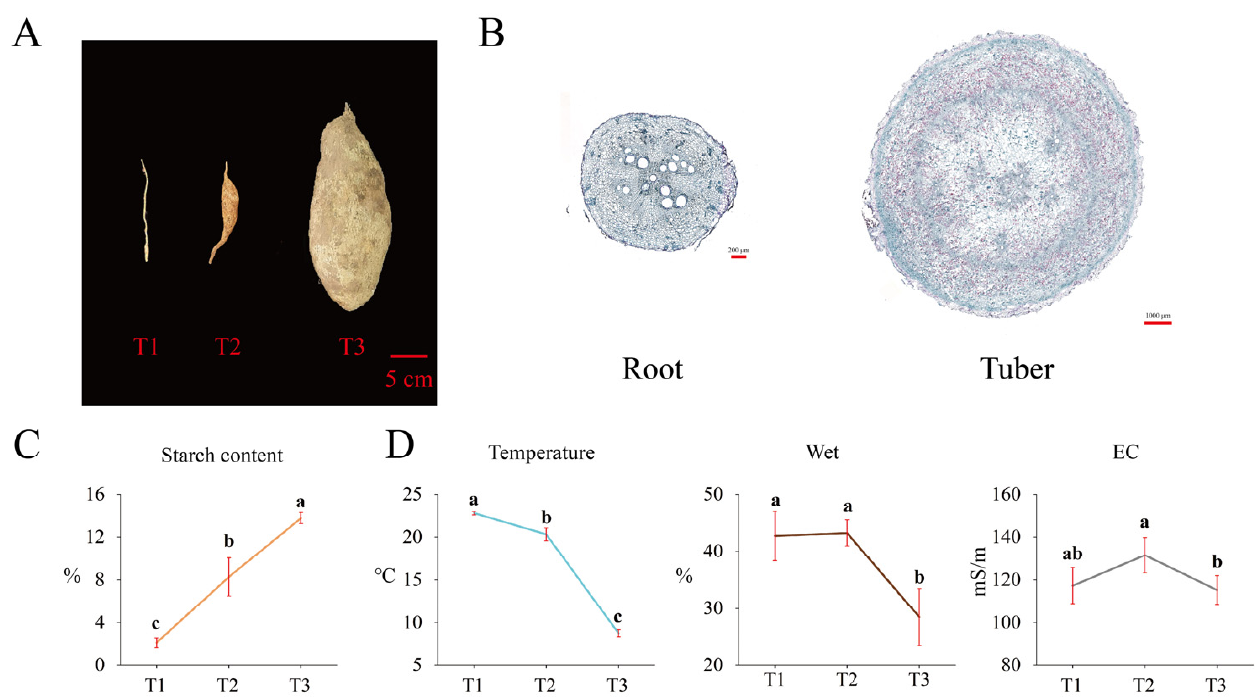
Figure 2. Starch accumulation and soil physical properties at three different stages of tuber growth. Photographs of tubers at stages T1, T2, and T3 ( A ). Microscopic view of a root and a tuber cross- section ( B ). Starch content ( C ) and soil physical properties at stages T1, T2, and T3 ( D ).